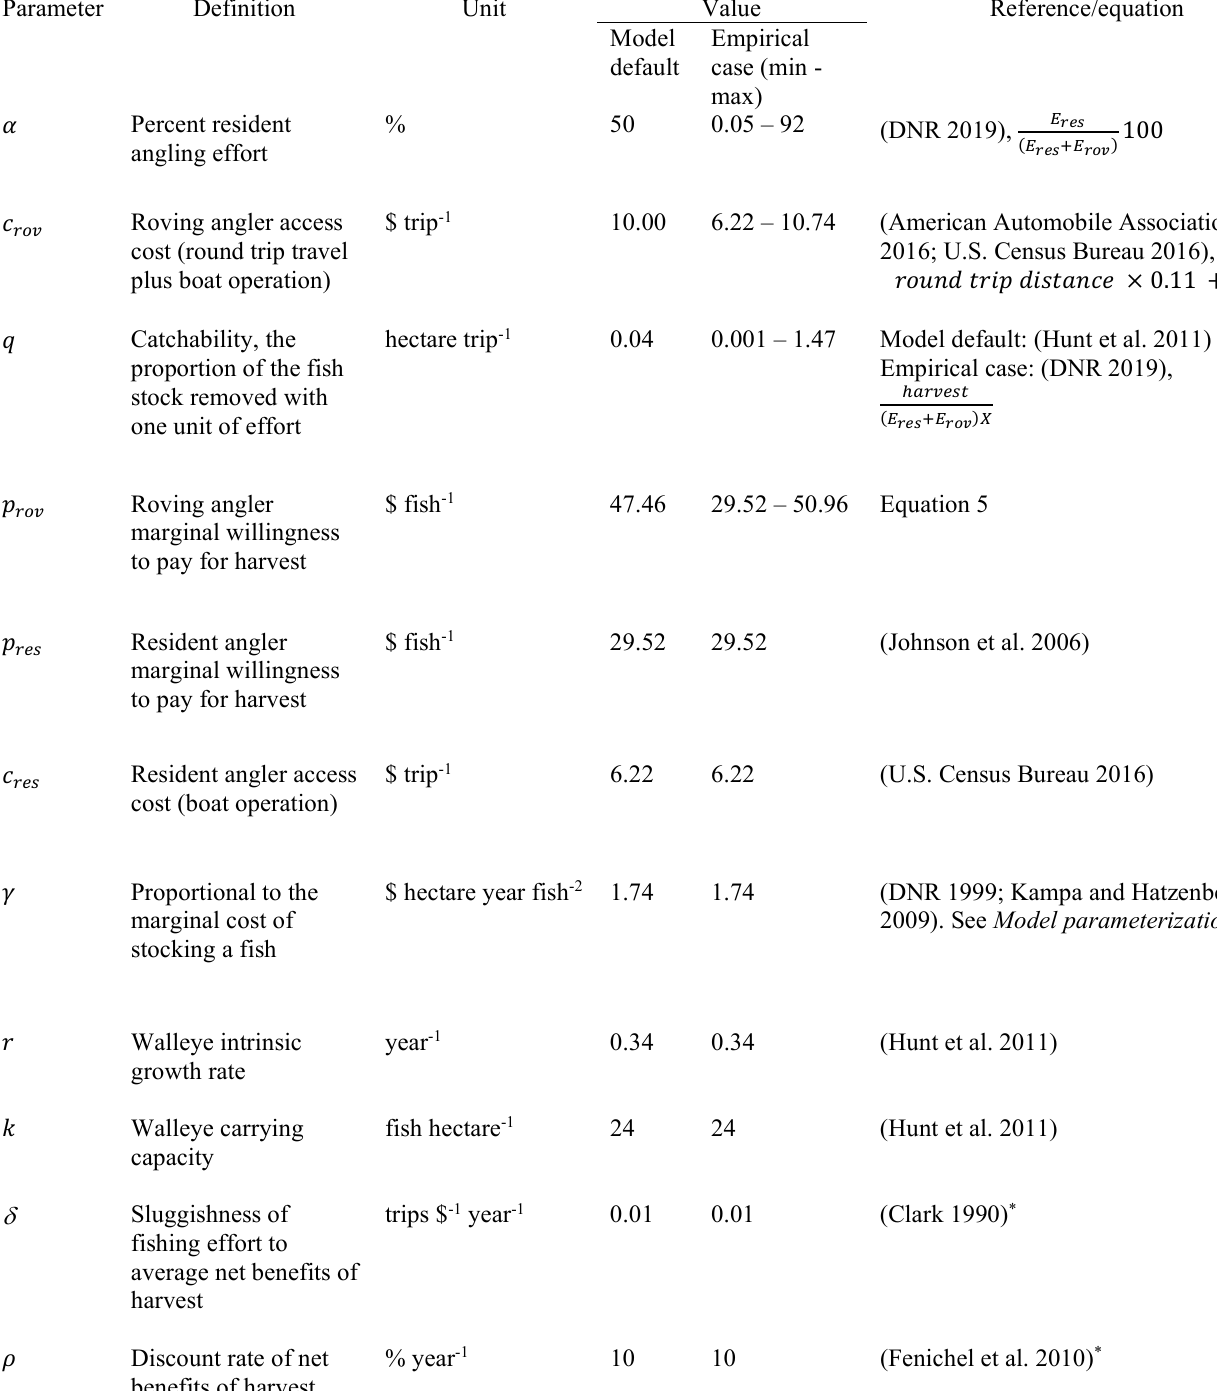
Table A1.1. Parameter values for bio-economic stocking model. Prices in 2016 U.S. dollars.